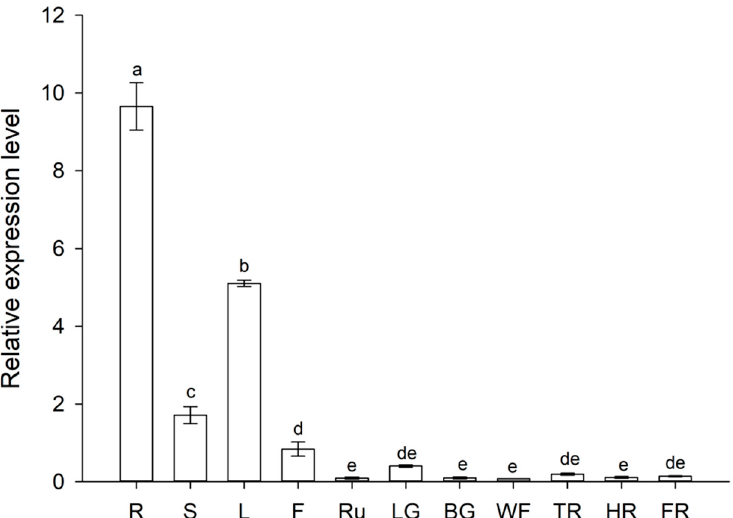
Figure 8. Relative expressions of FaZAT10 in different tissues and developmental stages of fruits. R: root; S: stem; L: leaf; F: flower; Ru: runner; LG: little green; BG: big green; WF: white fruit; TR: turn red; HR: half red; FR: full red. Data contain three biological replicates, error bars represent standard error of the mean, and different letters are represented by the least significant difference test (LSD), p < 0.05.